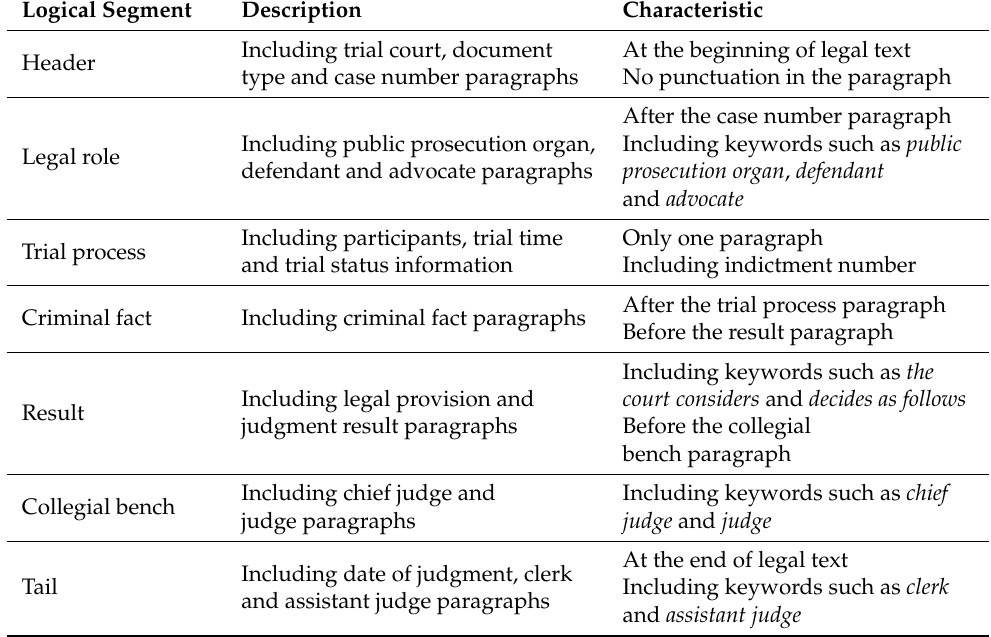
Table 1. Structural characteristics of each logical segment in Chinese legal